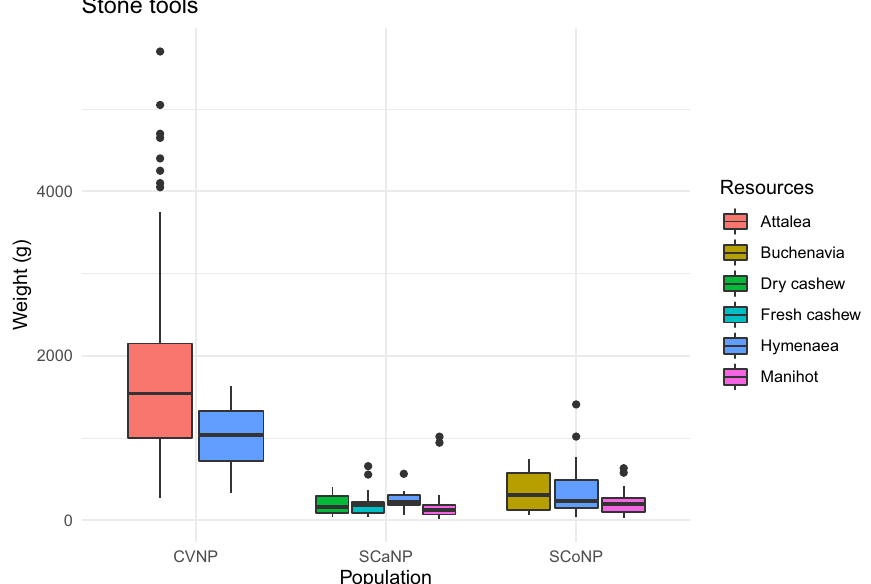
Figure 4. Hammerstone tool weight to process each resource at each